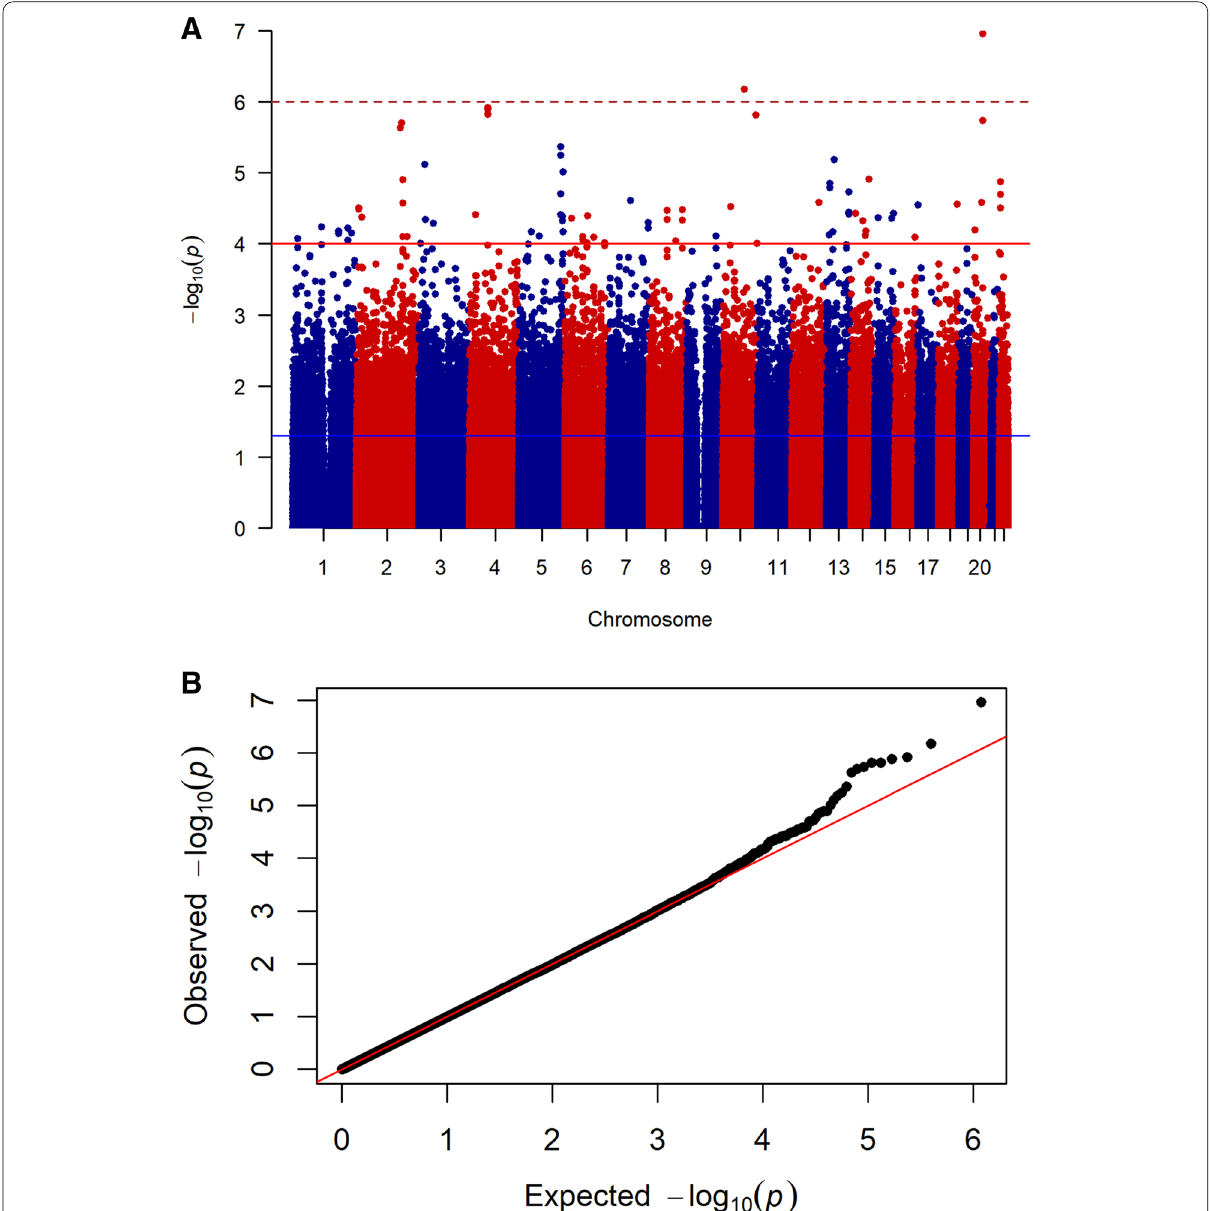
Fig. 1 A Manhattan plot for RLS association in patients with migraine. Manhattan plot of the discovery genome‑wide association analysis of 115 cases and 635 controls. The x axis is chromosomal position, and the y axis is the significance (–log 10 P ) of association derived from Cochran– Armitage trend tests. B Quantile–quantile plot of results from the Cochran‑Mantel–Haenszel analysis. Red line represents the distribution of P values under the null hypothesis, given a study inflation factor (λ) of